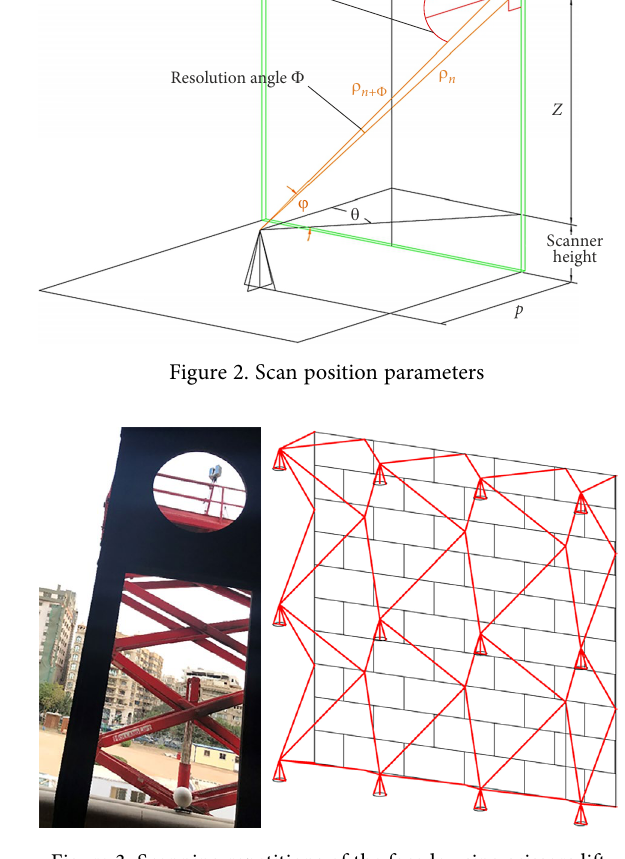
Figure 3. Scanning repetitions of the façade using scissors